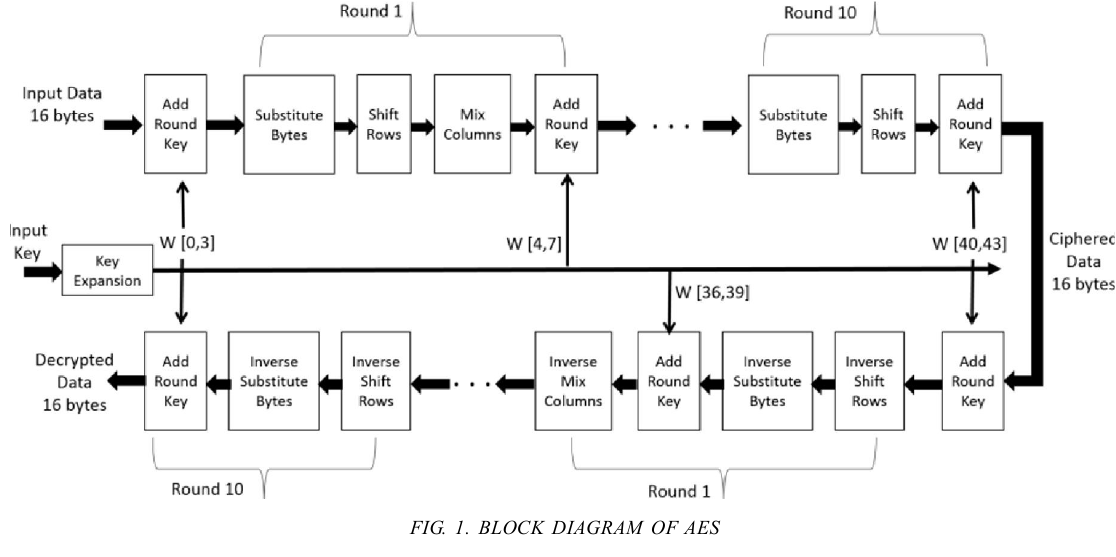
FIG. 1. BLOCK DIAGRAM OF